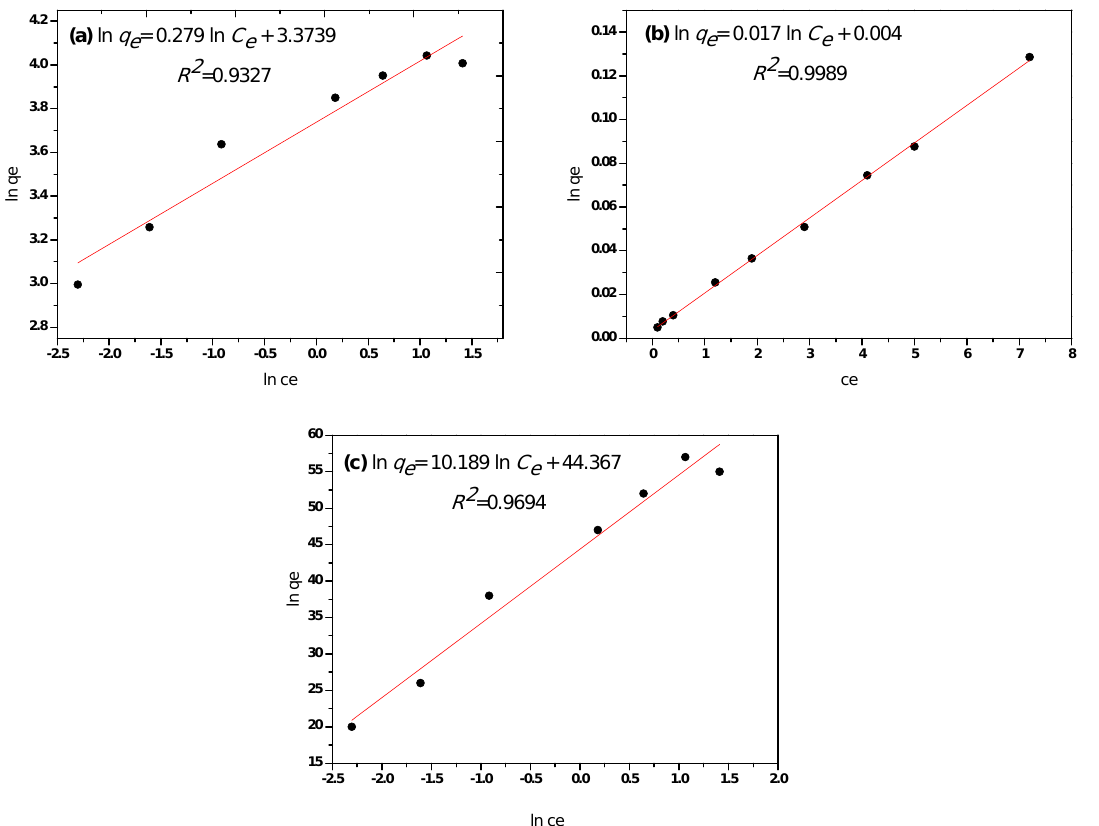
Figure 11. The linear isotherms of ( a ) Freundlich, ( b ) Langmuir, and ( c ) Temkin. Table 7. Parameter values for the different linear models.